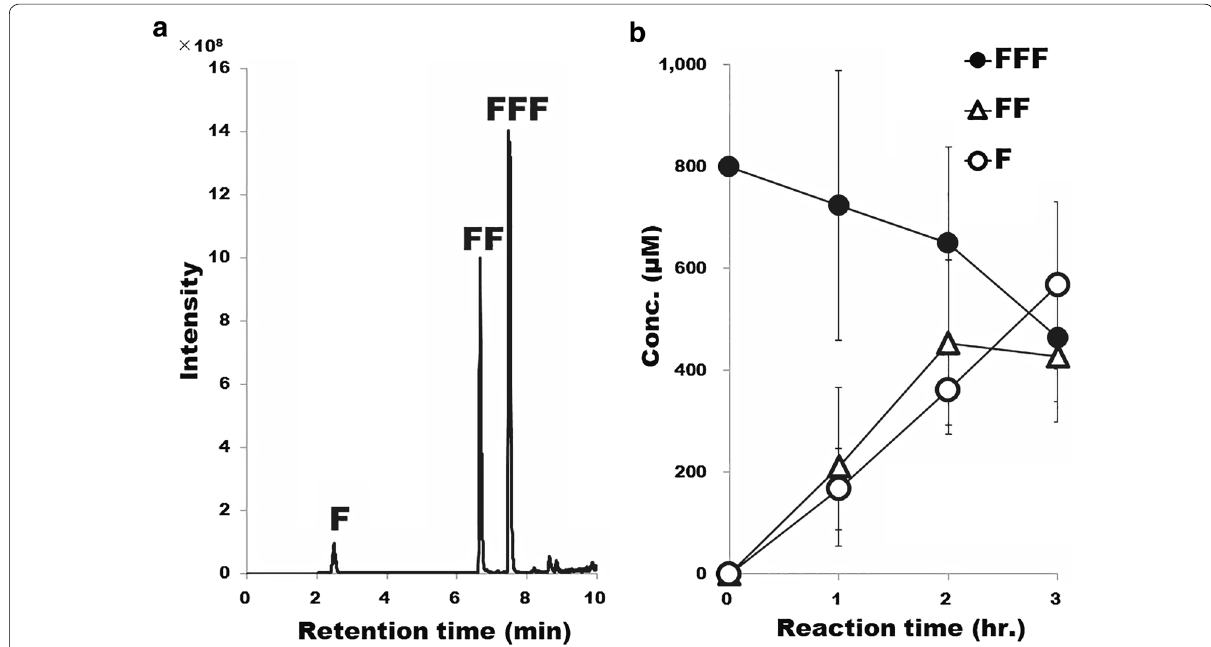
Fig. 4 Evaluation of the hydrolysis of Phe-Phe-Phe by XPO DUET. a Pattern of the base peak chromatogram of the standards. b Time course of hydrolysis of Phe-Phe-Phe by XPO